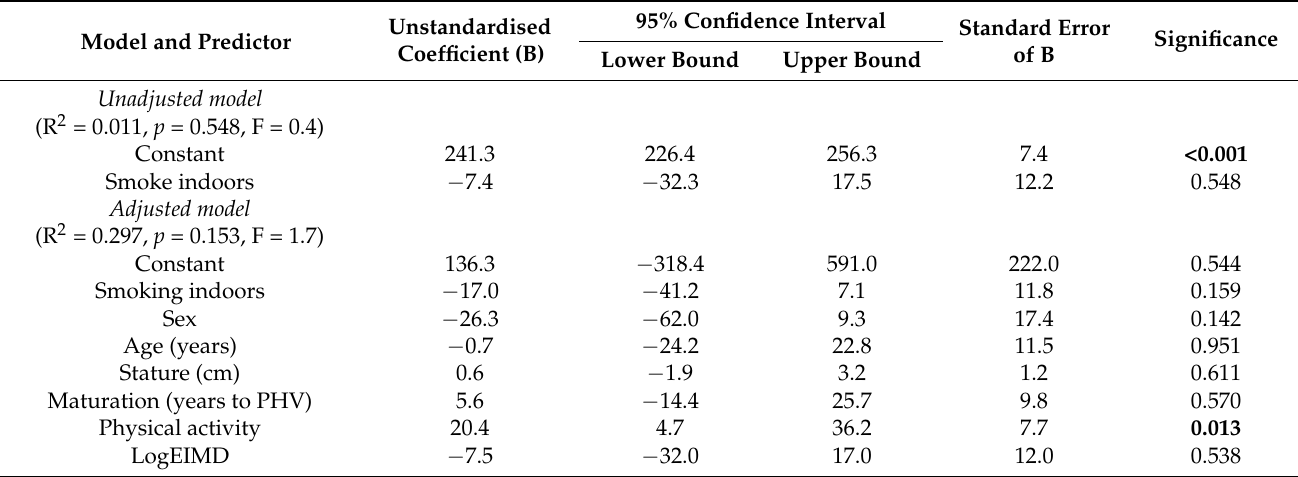
Table 3. Linear regression models examining association between indoor and outdoor smoking and allometrically scaled VO 2peak (mL · kg − 0.53 · min − 1 ) among children from smoking households (n = 38). Model and Predictor